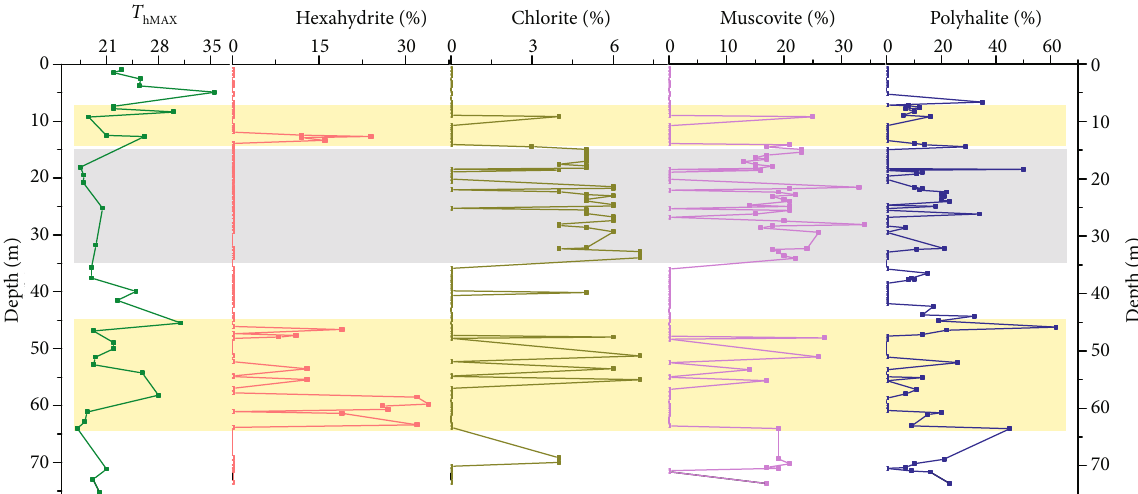
Figure 8: Plots showing concentrations of di ff erent minerals along the depth of the borehole and its relationship with T